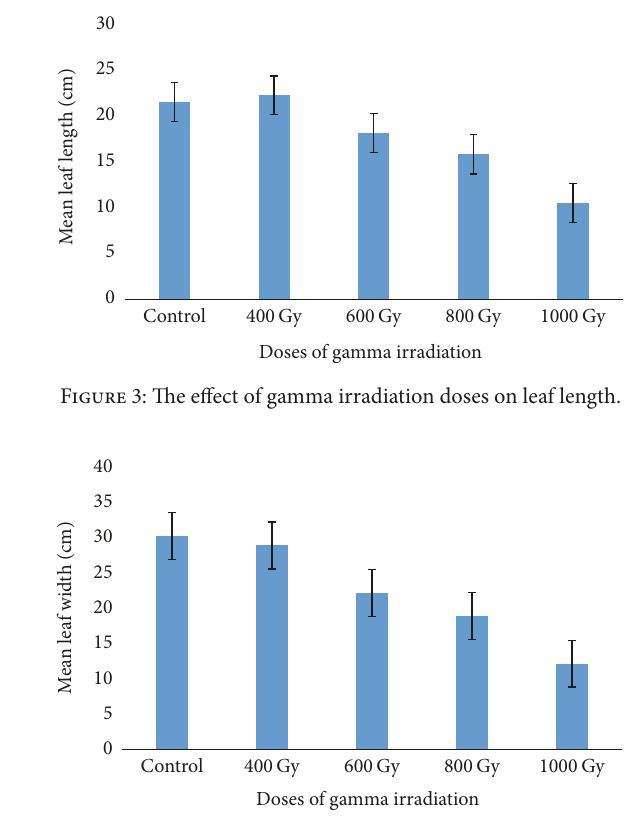
Figure 4: The effect of gamma irradiation on mean leaf